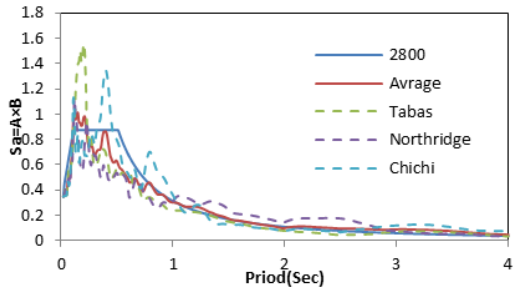
Fig. 5. Variation of spectral acceleration with period of